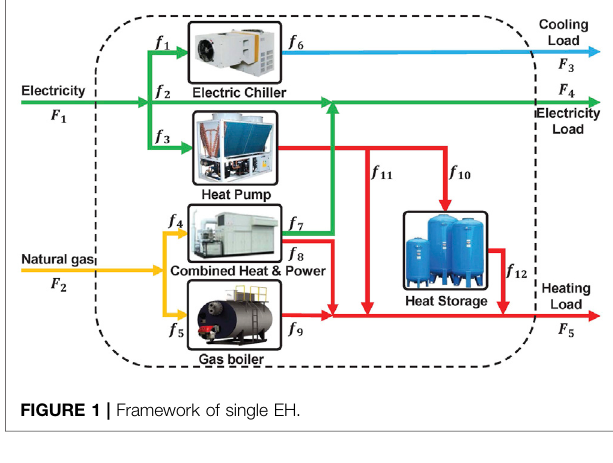
FIGURE 1 | Framework of single